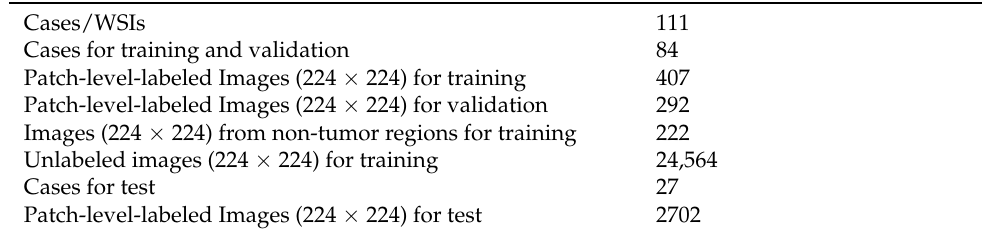
Table 2. Summary of the in-house